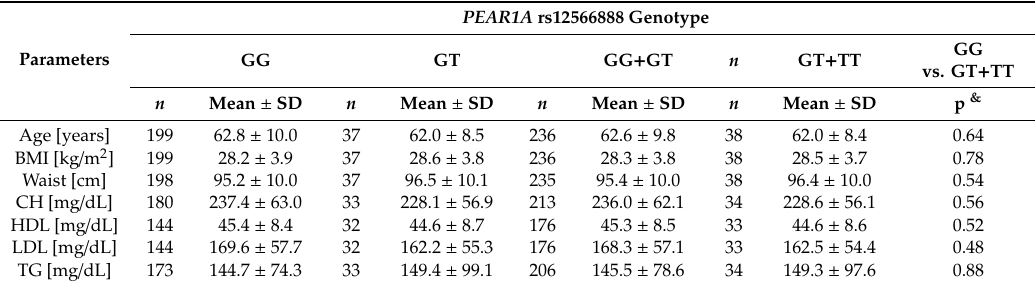
Table 3. Associations between the clinical parameters of patients with unstable angina and the PEAR1A rs12566888